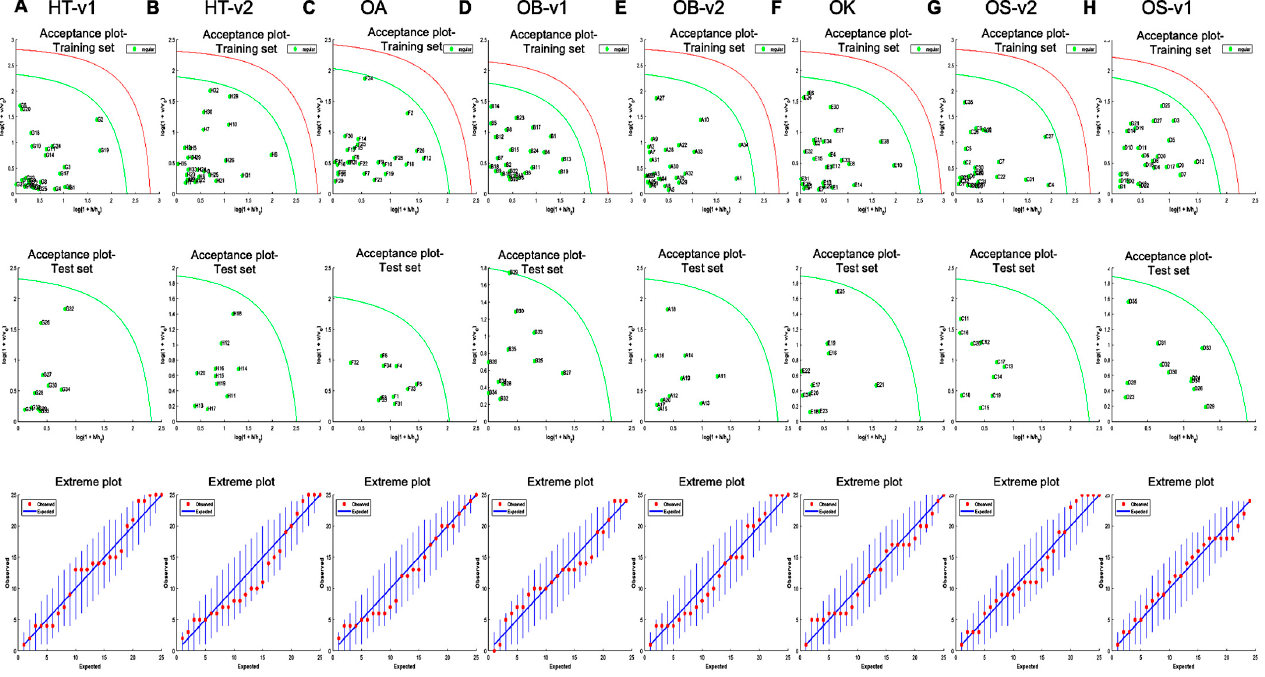
Figure 7. The application of DD-SIMCA for the classification of Ocimum samples from ( A ) HT-v1—Hybrid Tulsi variety 1; ( B ) HT-v2—Hybrid Tulsi variety 2; ( C ) OA— O. africanum ; ( D ) OB-v1— O. basilicum variety 1; ( E ) OB-v2— O. basilicum variety 2; ( F ) OK— O. kilimandscharicum ; ( G ) OS-V2— O. sanctum variety 2; ( H ) OS-V1— O. sanctum variety 1. Acceptance plots for training set and test set shown one to one below and the corresponding extreme plots for each training set shown far down to the acceptance plots. The acceptance plot for training set provides a graphic representation of the acceptance area, the area inside the green curve and the red line is the outlier cut-off with threshold α = 0.01. Authentic samples falling outside the green curve were considered extremes